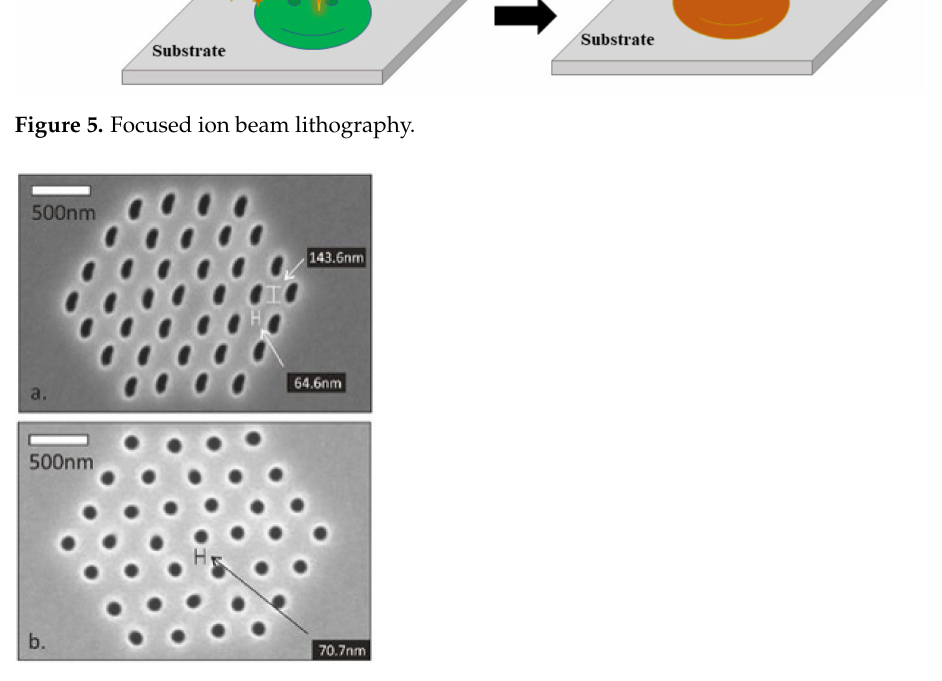
Figure 6. Nanopore arrays fabricated by Ga + ion milling in bare ( a ) and metallised ( b ) silicon-nitride membranes. The distorted pore geometries are result of the beam defocusing effect of electrically charged dielectric membrane